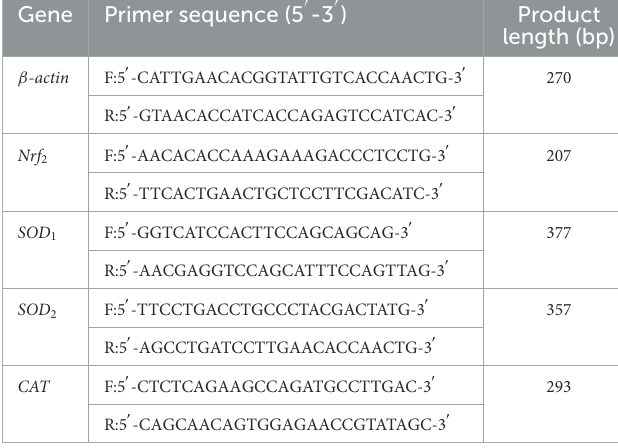
TABLE 2 Primer design for hepatic antioxidant gene assay by